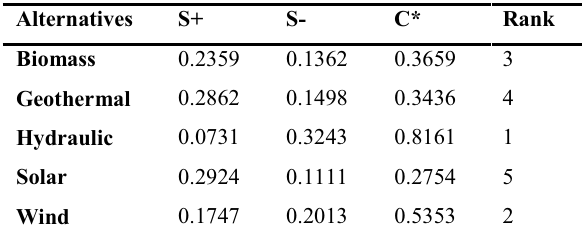
Table 8: Preference